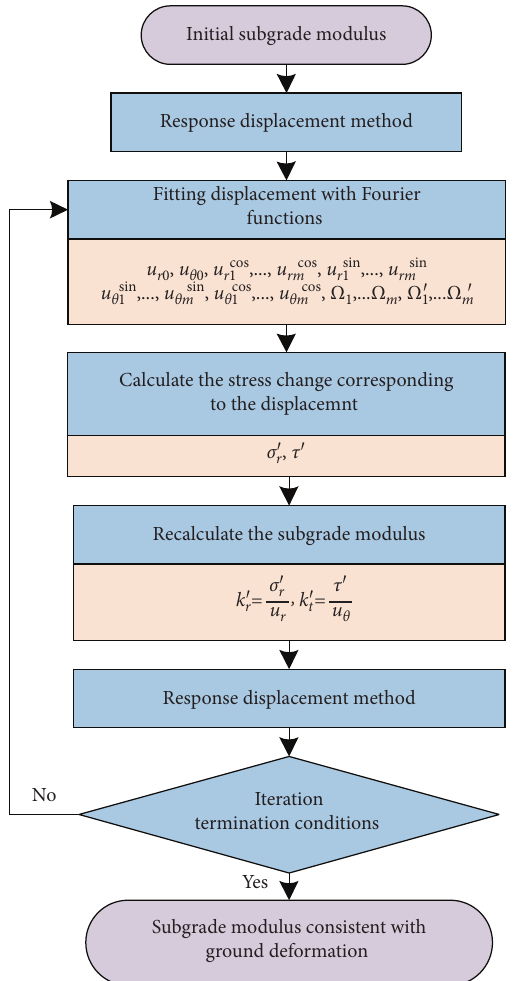
Figure 3: Flowchart for displacement fitting